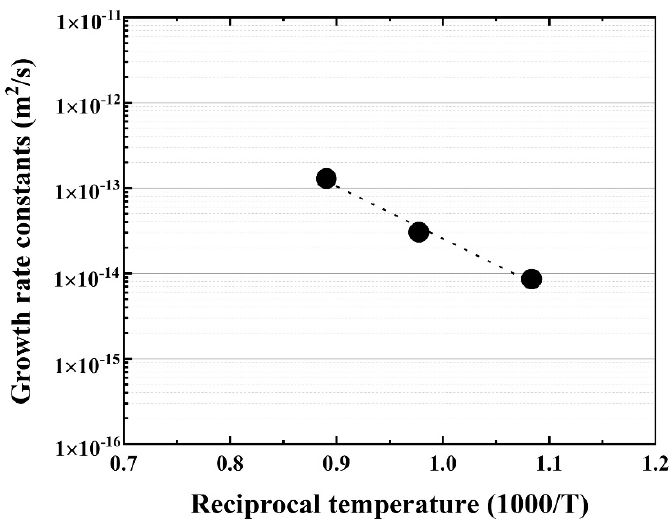
Figure 6. Arrhenius plot of the reaction layer as a function of reciprocal temperature. Good linearity was obtained, and the activation energy for the growth rate of the reaction layer was 116.2 kJ/mol, which is similar to that of Cu–Al intermetallic compound [22] and lower than that of β –Ti in Ti alloys [20]. The bonding strength of the Be/F82H joint was evaluated (Figure 7). It indicates that the bonding strength is inversely proportional to the thickness of the joint between Be and F82H. This inverse trend is because the increased thickness of the reaction layer comprising Be 12 Fe, Be 5 Fe, and Be 2 Fe decreased the bonding strength, which is in good agreement with the results in [17]. It is noted that all specimens were fractured at the joined area, in other words, it does not depend on the structure variation of the substrates, F82H and Be, even though those specimens were heat-treated at a temperature higher than the tempering temperature at 1023